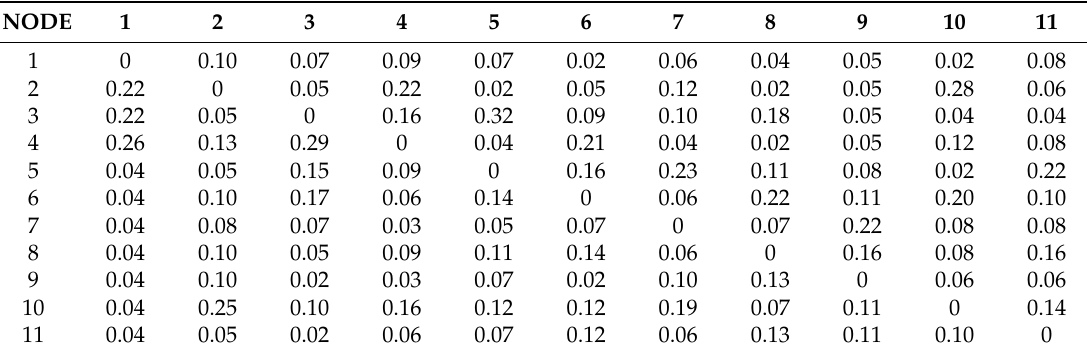
Table A3. Real Madrid’s matrix of state in-transition